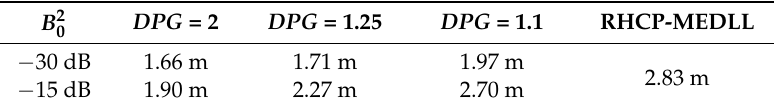
Table 4. The RMSE of the DP-SIMLE algorithm as the DPG decreases.